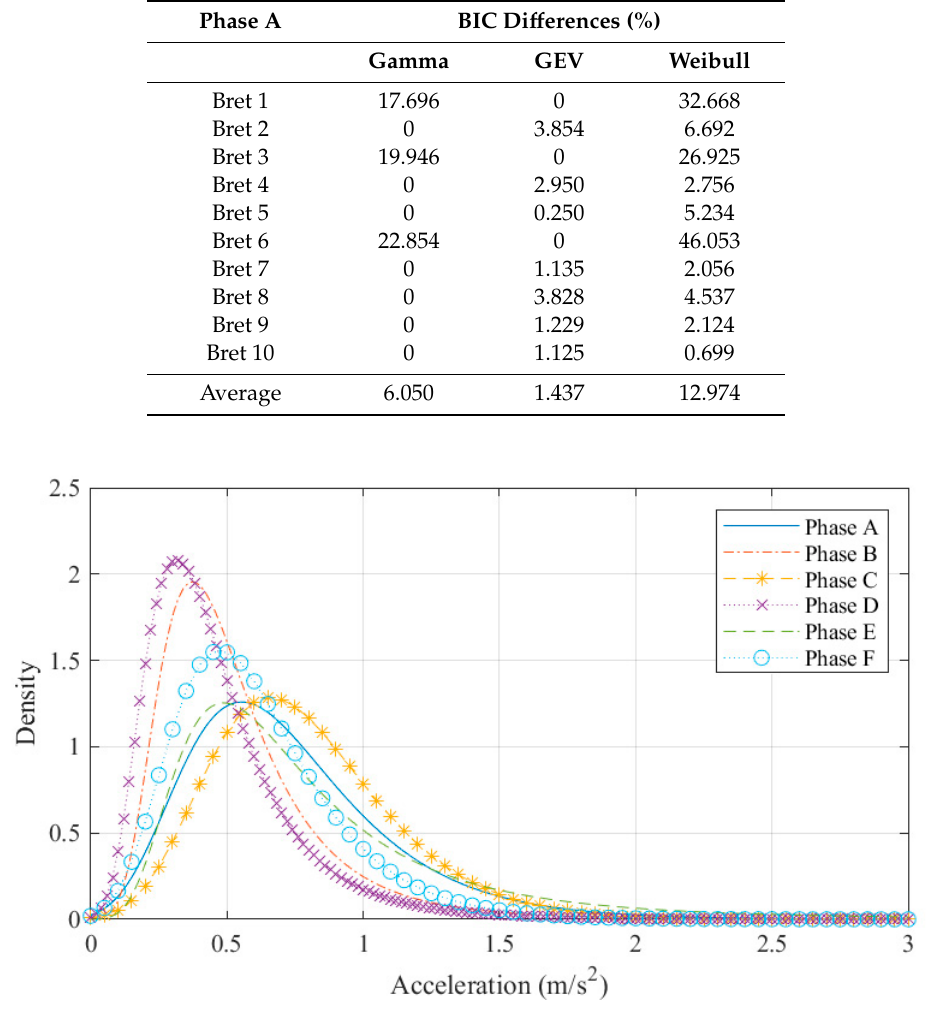
Figure 15. GEV fit for acceleration data for all phases of testing, for wave case Bret 8.